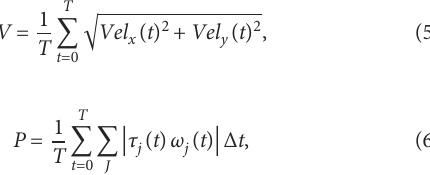
and ℝ . Three random seeds are 1 2